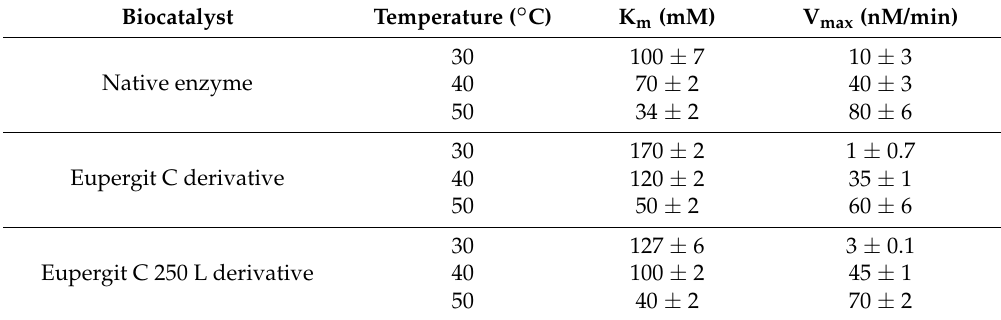
Table 3. Kinetic parameters of soluble L -arabinose ( D -galactose) isomerase and derivatives. 1